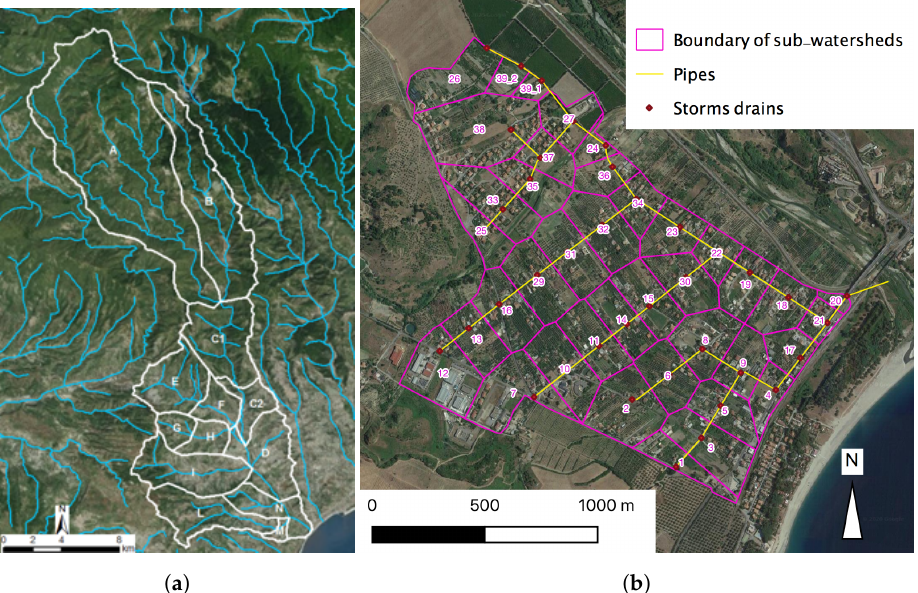
Figure 6. Discretisation of the Corace watershed (Calabria, Southern Italy) in hydrologically homogenous units using the MIKE models (( a ) entire watershed; ( b ) urban area with the delineated sub-watersheds - in red lines - and the sub-surface drainage network - in yellow